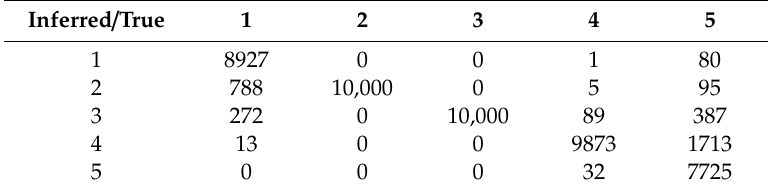
Figure 12. PC 2 versus PC1 for 5 common naturally occurring materials for ( a ) 5 min count time without variation in the detector response function (DRF) and ( b ) 0.5 min count time with item-specific variation in the model bias as described. Table 1. Confusion matrix for 50,000 test cases with 10,000 simulated in each of naturally occurring radioactive material (NORM) groups 1–5. The true group is in the column and the inferred group is in the row.